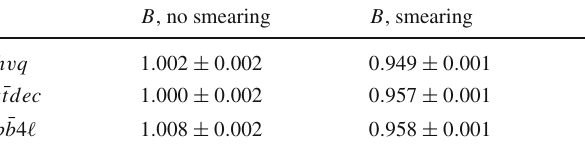
Table 2 Values for the B coefficients of Eq. (8) for the m Wb position, for the non-smeared and smeared distributions (see Sect. 6.1 fordetails),obtainedwiththe h v q , t ¯ tdec and b ¯ b 4 (cid:4) generatorsshowered with Pythia8.2